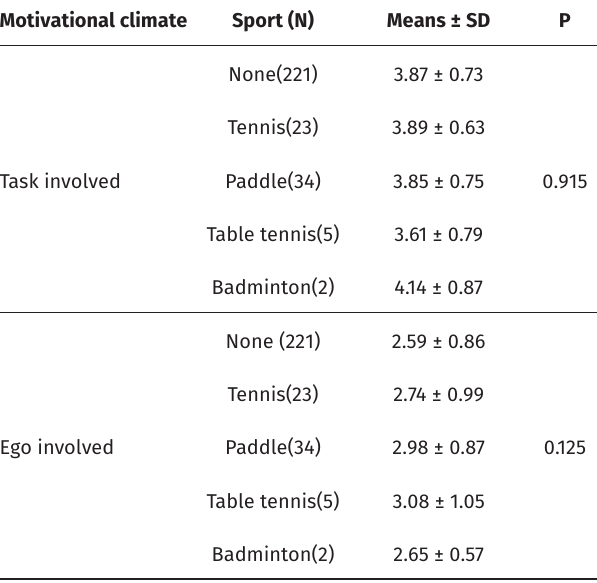
Table 2. Task and ego involved depending on the type of racket sport practiced by all the